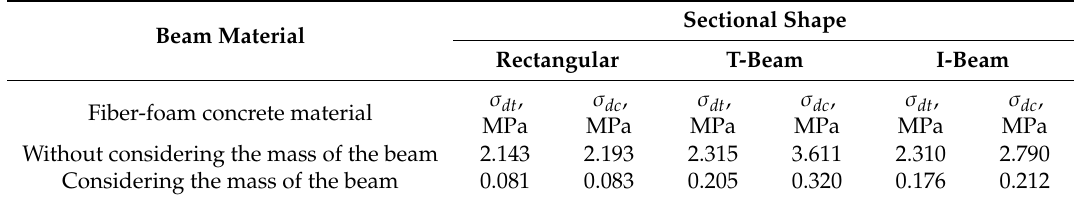
Table4. Maximumdynamicstressesarisinginbeamsofrectangular, T-andI-shape, withoutbimodularity. E t = 7500 MPa; E c = 7500 MPa.